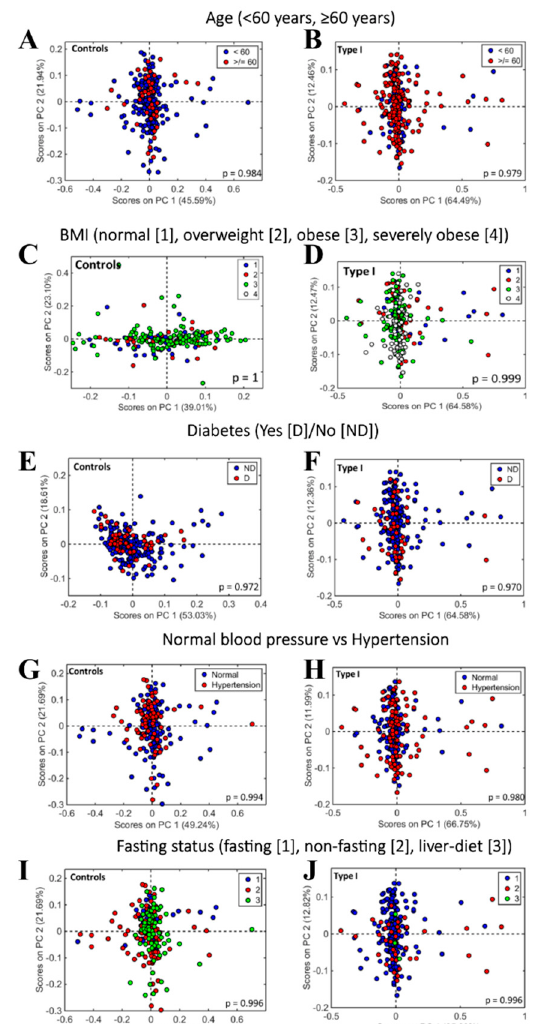
Figure 5. Score plots generated after unsupervised principal component analysis (PCA) to visualize differences and similarities according to confounding factors. ( A,B ) Score plots according to age (<60 years; ≥ 60 years) for controls ( A ) and Type I cancers ( B ). ( C , D ) Score plots according to BMI (normal: BMI = 18.5–24.9; overweight: BMI = 25–29.9; obese: BMI = 30–39.9; severely obese: BMI > 40) for controls ( C ) and Type I cancers ( D ). ( E , F ) Score plots according to diabetes (diabetic; non-diabetic) for controls ( E ) and Type I cancers ( F ). ( G , H ) Score plots according to fasting status (fasting; non-fasting; liver diet) for controls ( G ) and Type I cancers ( H ). ( I , J ) Score plots according to blood pressure (normal; hypertension) for controls ( I ) and Type I cancers ( J